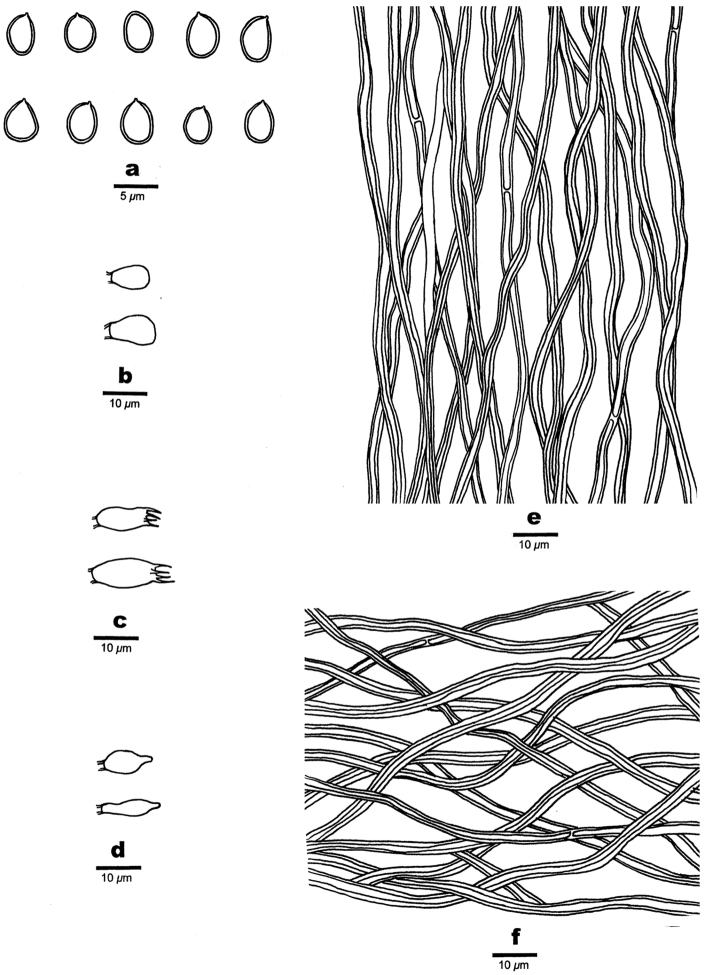
Microscopic structures of Fomitiporella
vietnamensis. a Basidiospores b Basidioles c Basidia d Cystidioles e Hyphae from trama f Hyphae from subiculum.